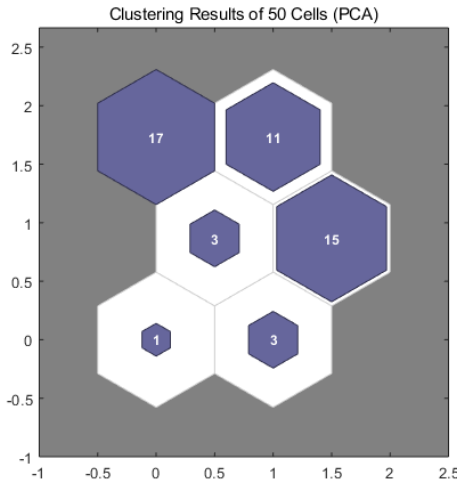
Figure 7. SOM clustering results of Group 1 (six neurons in the output layer). Table 5. Categories of 50 battery